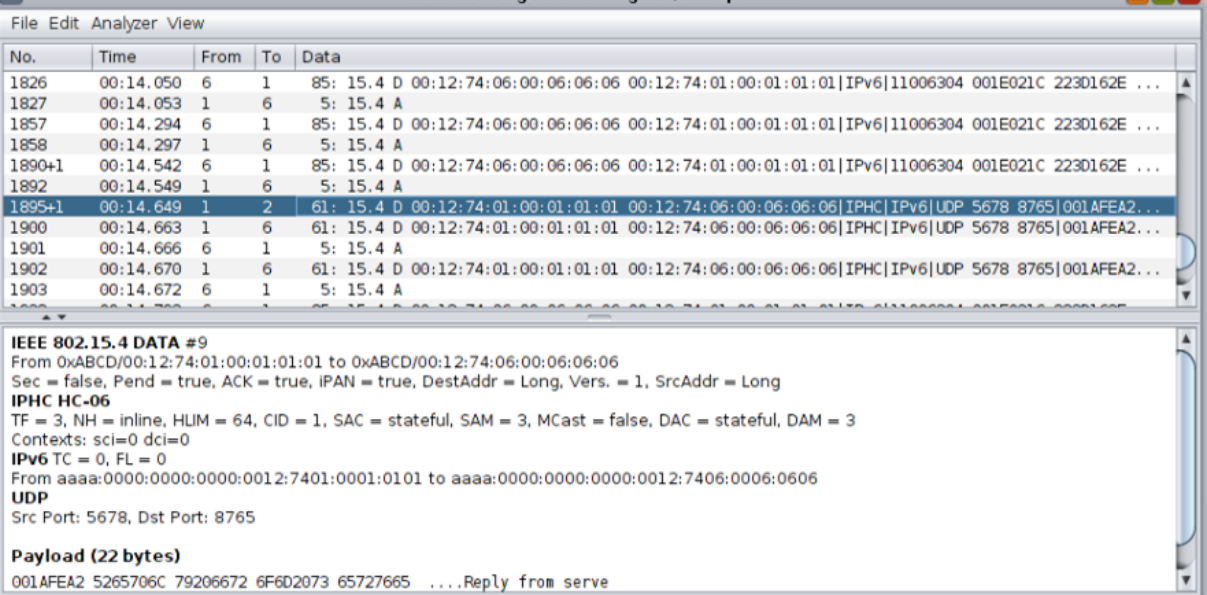
Figure 31. Network traffic information from the attack scenario in the “Radio messages” output window.